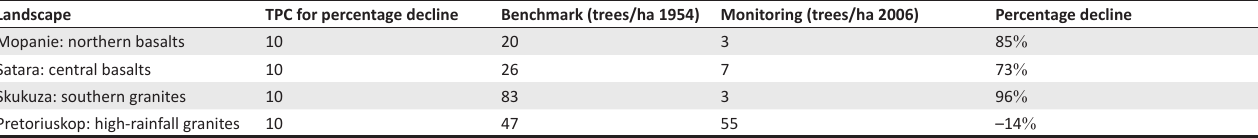
TABLE 4: Selected landscapes indicating the threshold of potential concern for loss of large trees (more than 5 metres), the benchmark and the subsequent survey data. Landscape TPC for percentage decline Benchmark (trees/ha 1954) Monitoring (trees/ha 2006) Percentage decline Mopanie: northern basalts 10 Satara: central